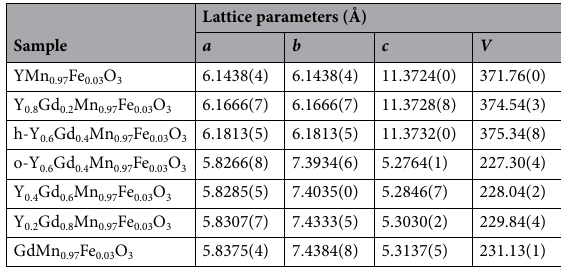
Table 1. Cell parameters of Y x Gd 1−x Mn 0.97 Fe 0.03 O 3 samples.